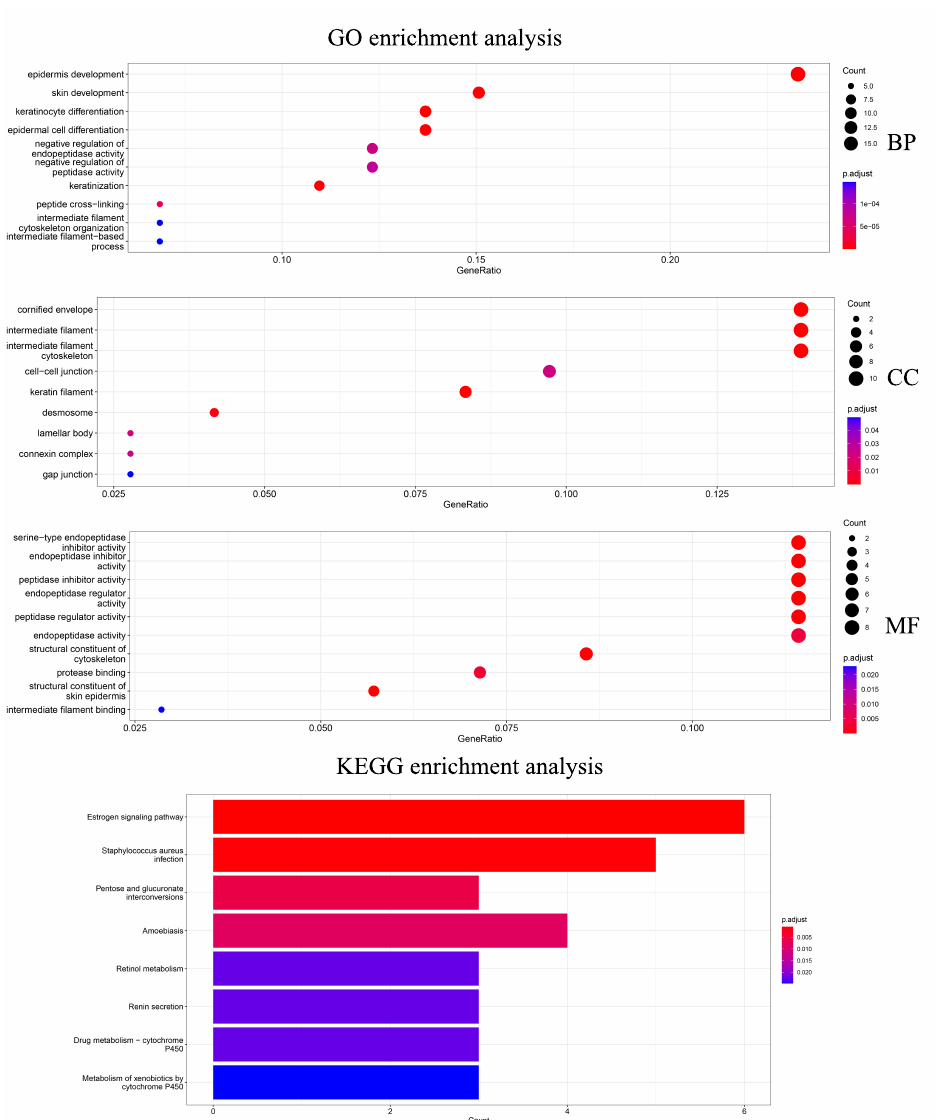
Figure 7. The GO enrichment analysis and KEGG pathway enrichment analysis of differentially expressed screening